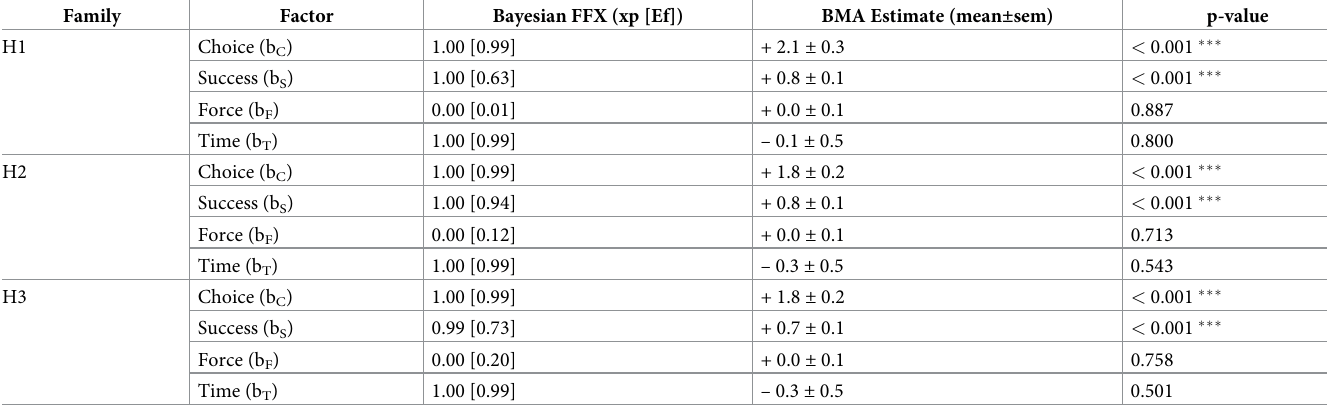
Table 2. Effects of action-related factors on all subsequent behaviors (rating, choice, success, force) in extended models (H0 to H3).